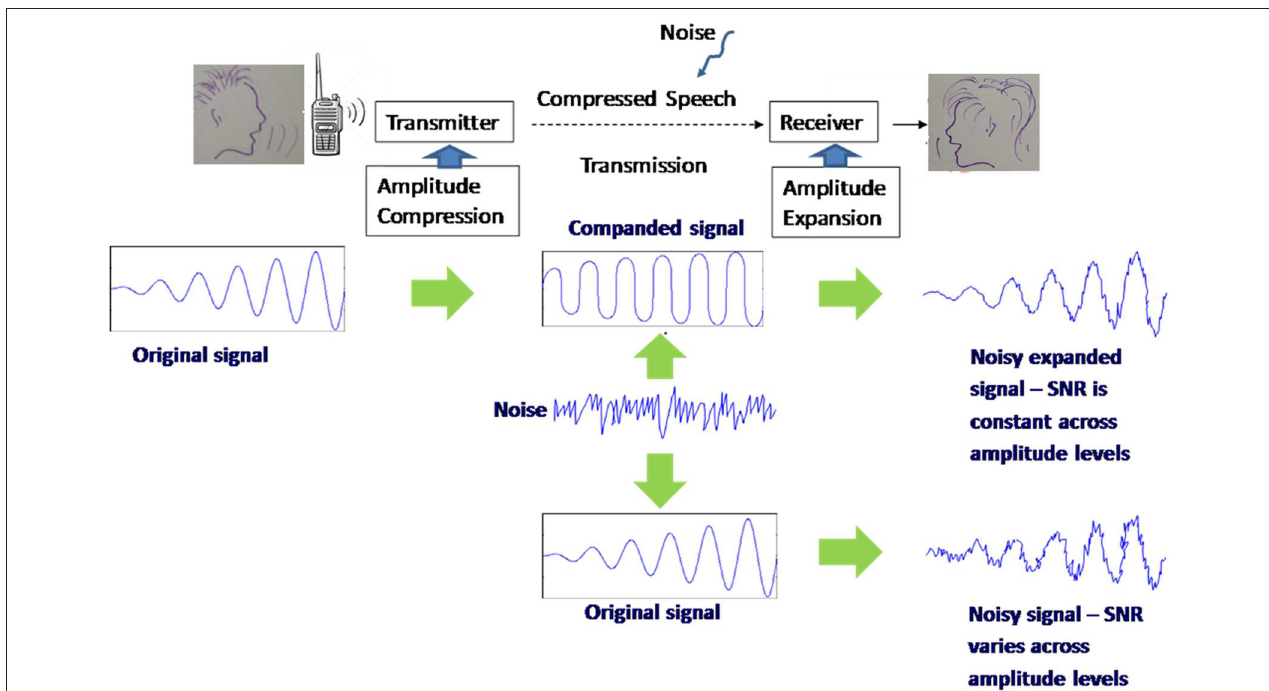
FIGURE 2 | The µ -law compression/expansion (companding)